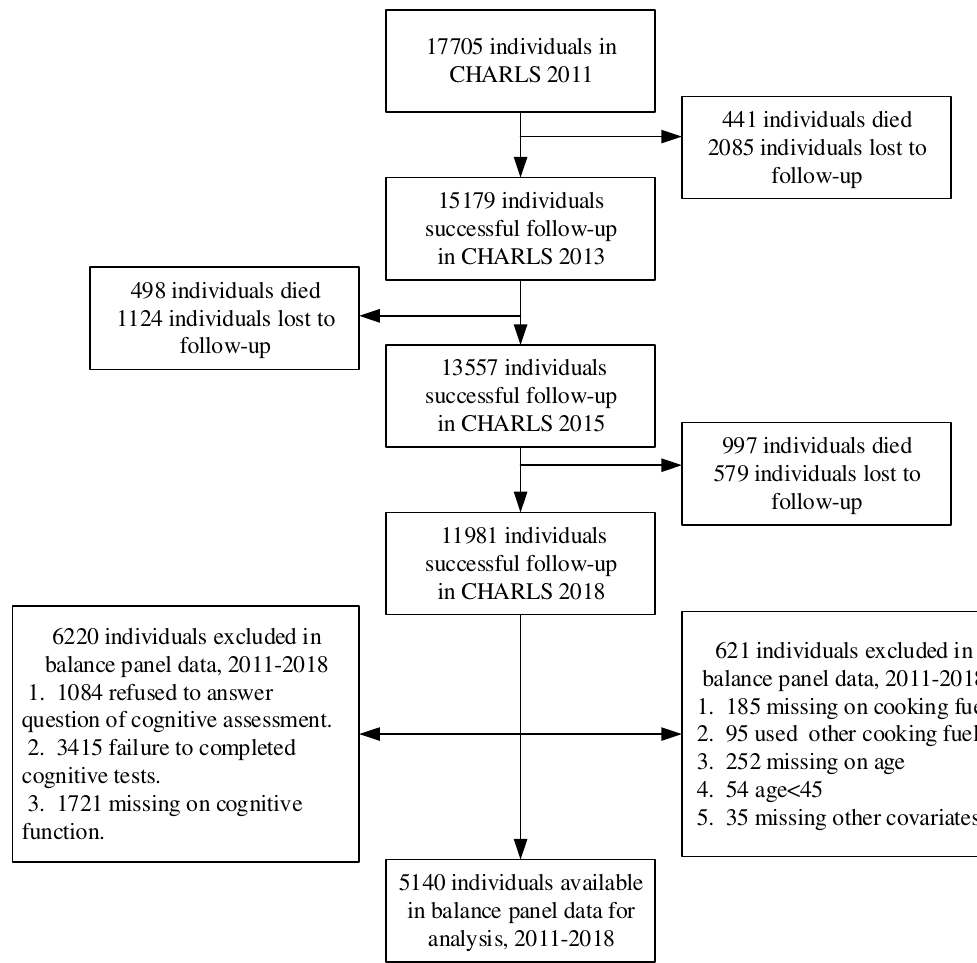
Figure 1. Flowchart of participant eligibility in the current